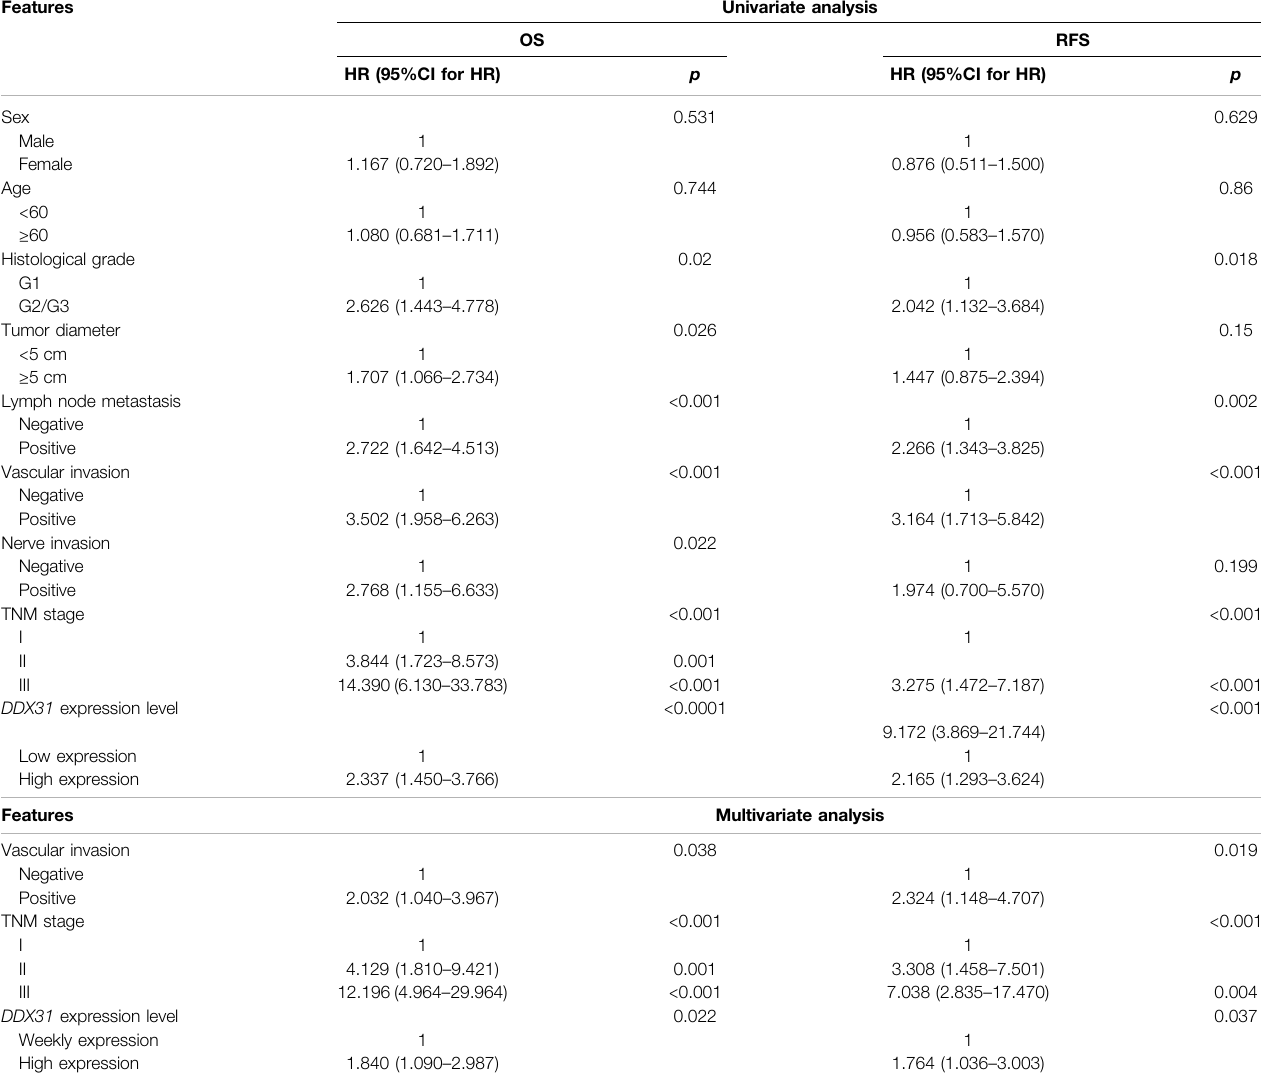
TABLE 2 | Univariate and multivariate analysis of clinicopathological factors for overall survival rate (OS) and relapsed-free survival rate (RFS).